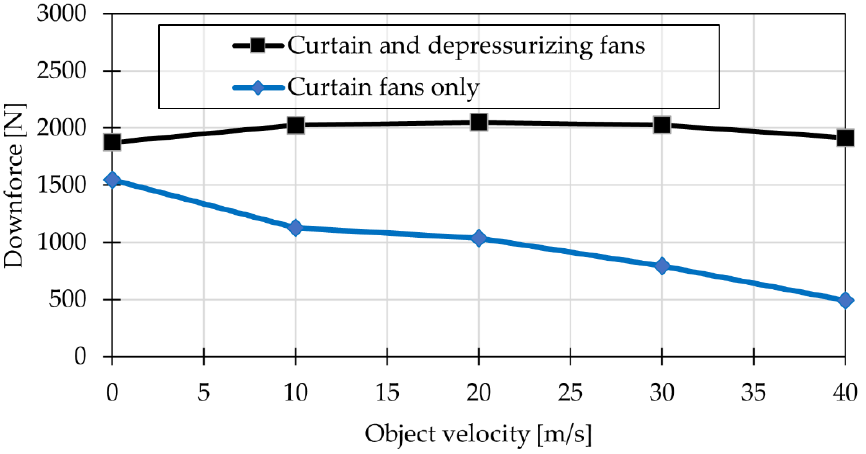
Figure 14. Comparison of the aerodynamic downforce achieved using only the air curtain fans and additionally supported by the depressurizing fan.